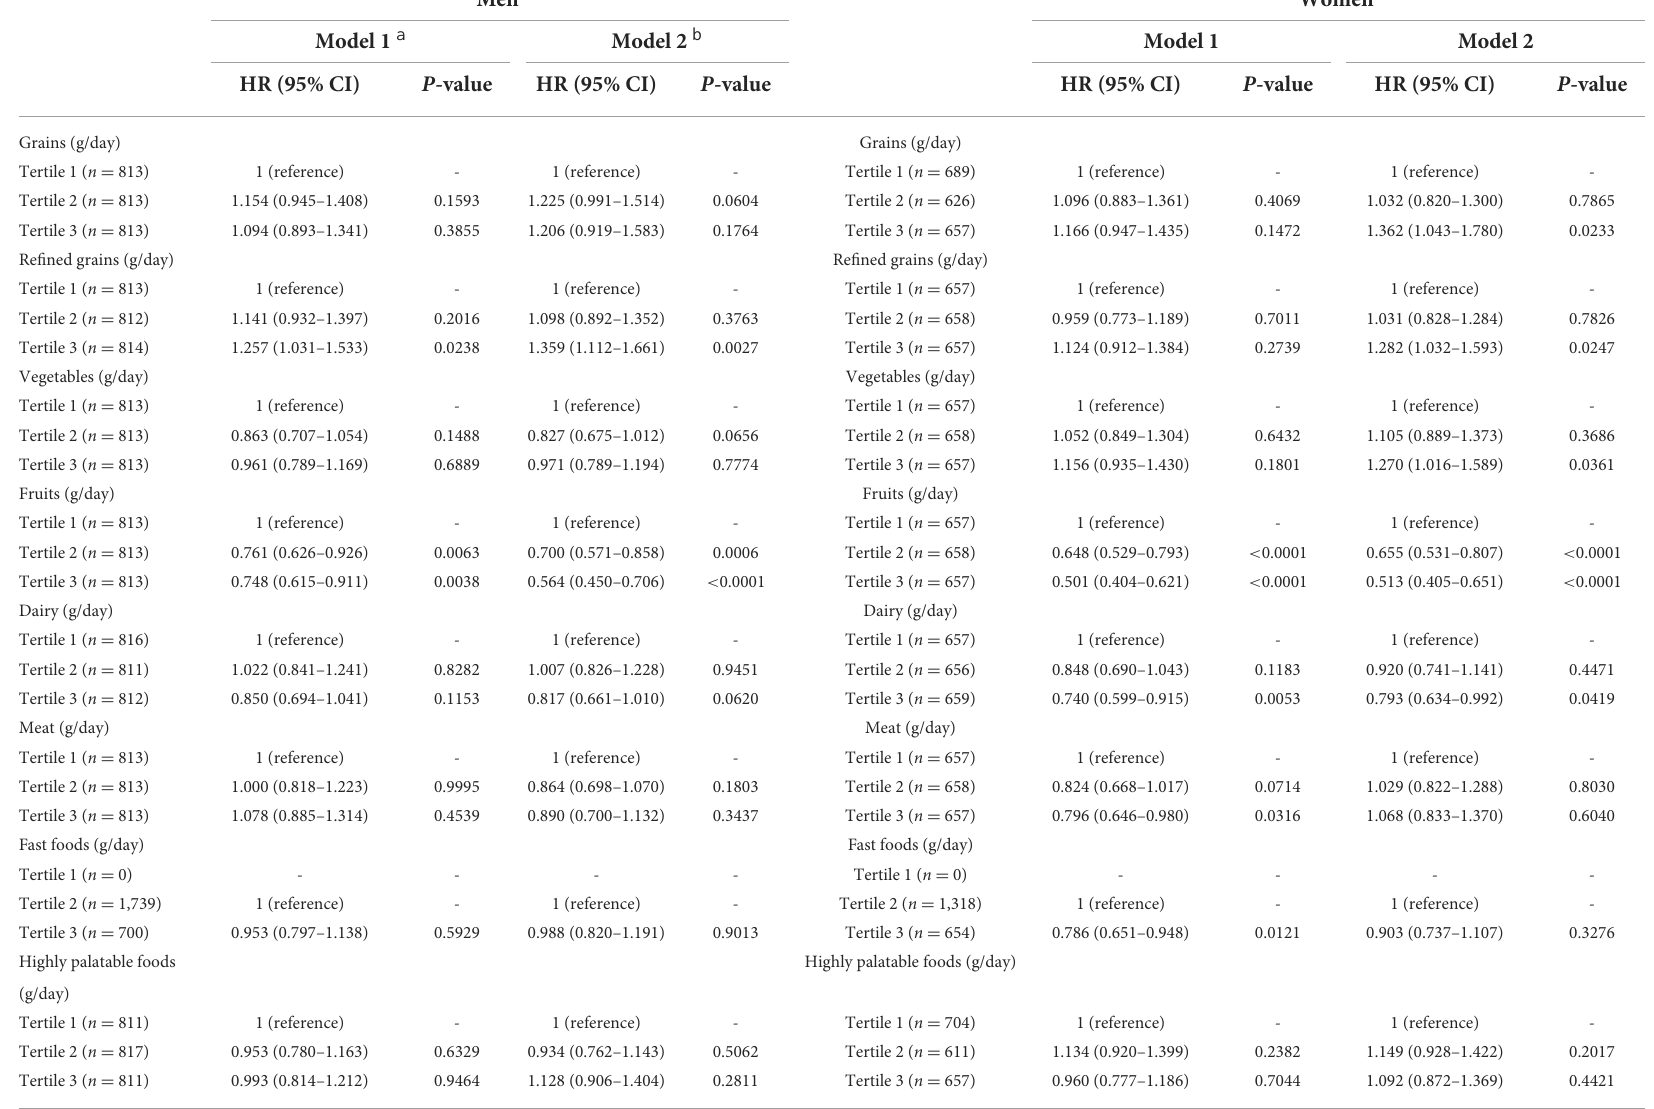
TABLE 5 Hazard ratios (HRs) and 95% confidence intervals (CIs) for the risk of abdominal obesity according to food